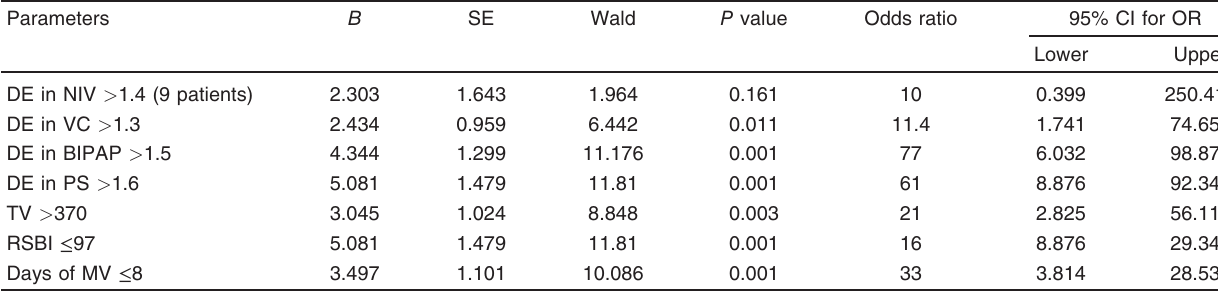
Table 6 Logistic regression analysis for predictors of successful weaning Parameters B SE Wald P value Odds ratio 95% CI for OR